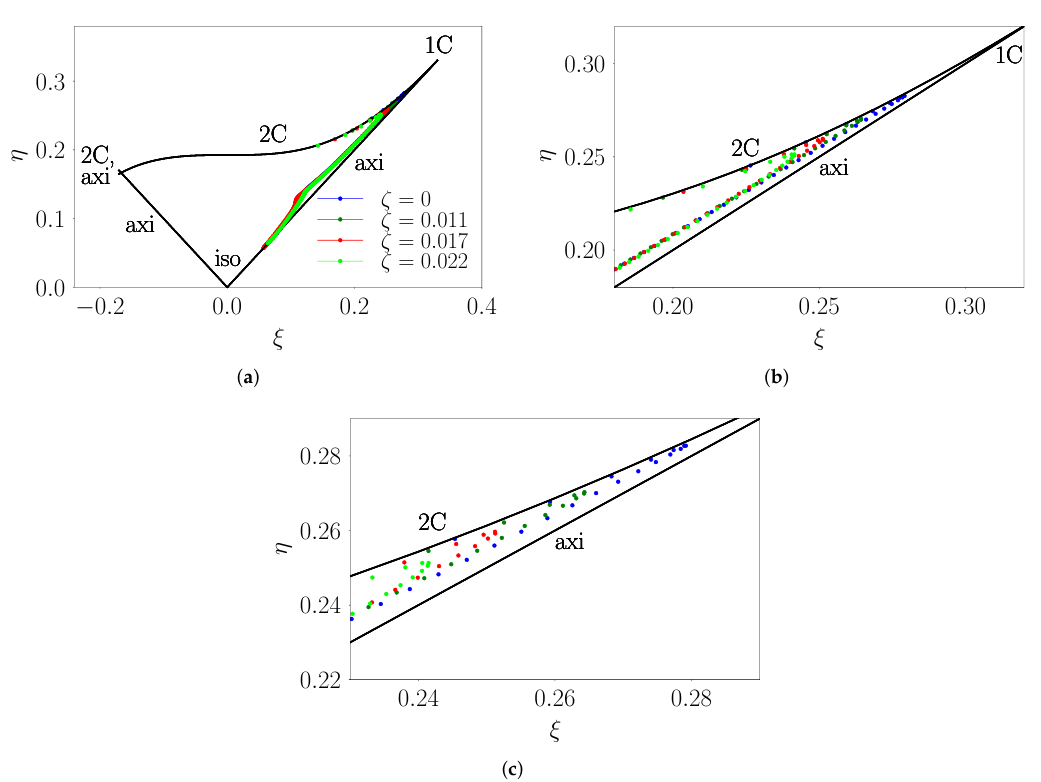
Figure 14a,b, increase in the positive peak of the viscous layer at higher values of ζ , indicative of the surface shape induced mixing that is different from turbulence induced stress. This negative value of higher momentum fluid particles move away from the wall due to up slope part of the wavy surface.